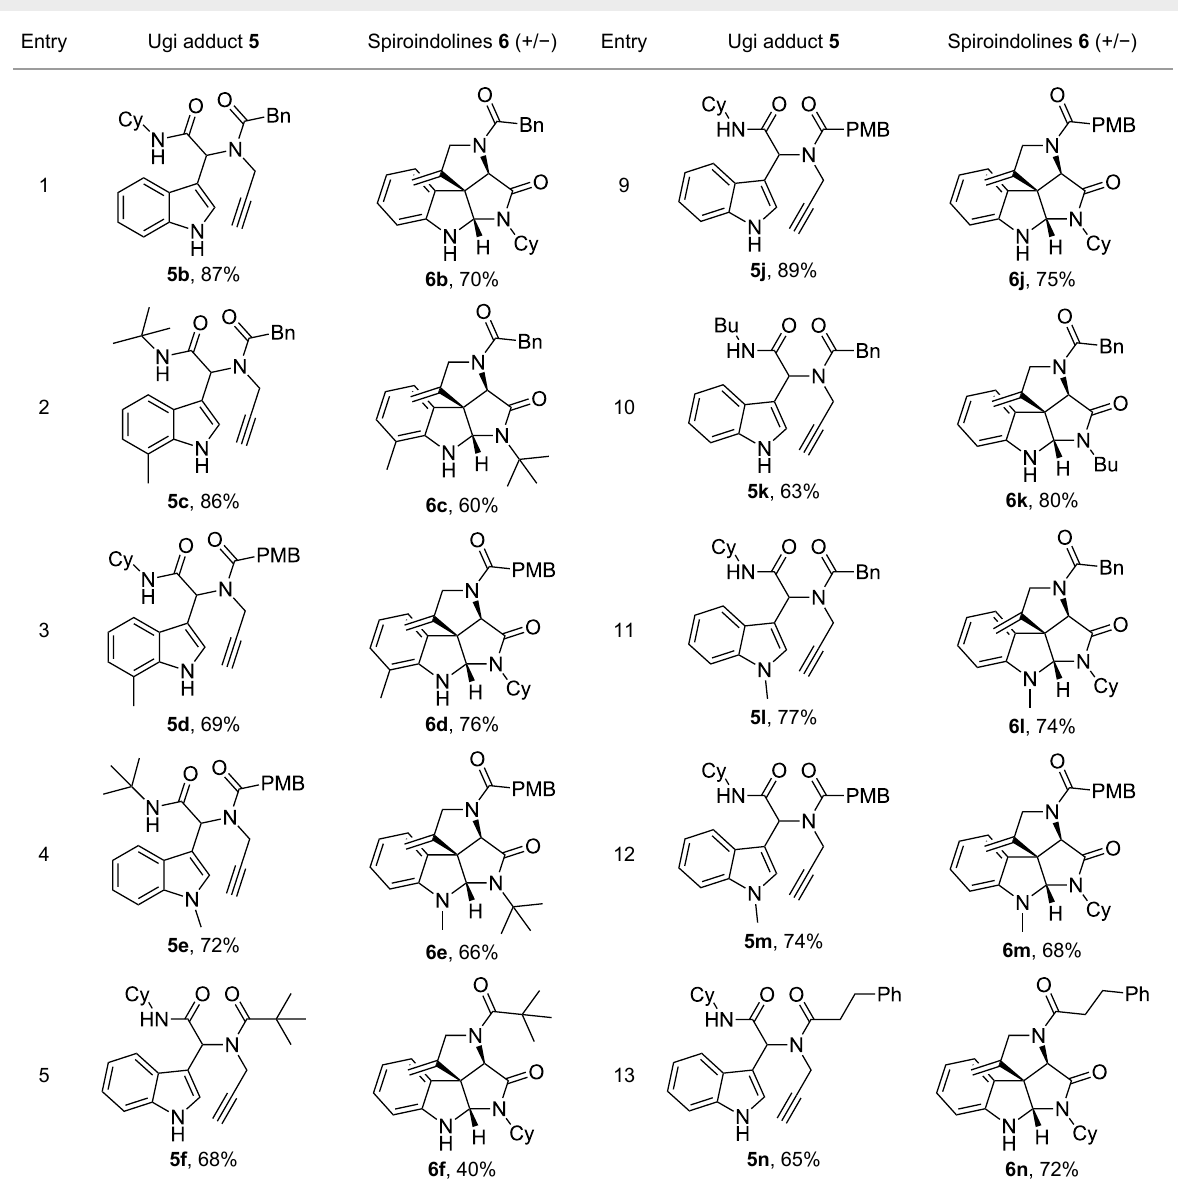
Table 2: Scope and limitations of intramolecular domino cyclization.